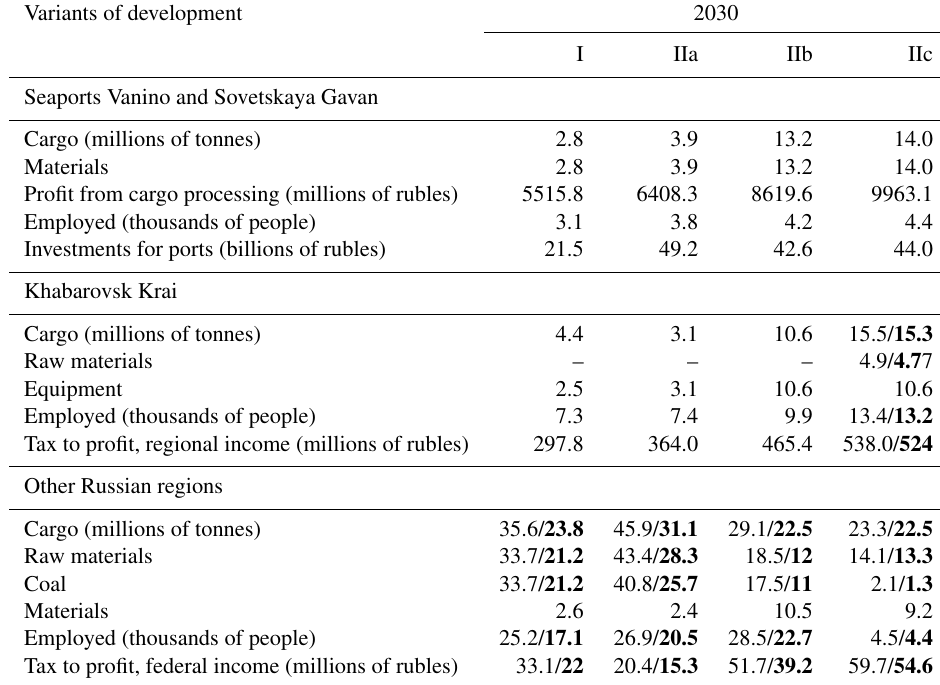
Table 2. Future state of seaports Vanino and Sovetskaya Gavan as beneficiaries to themselves, to Khabarovsk Krai and to the Russian Federation. Bold font indicates cases of environmental energy restructuring with a considerable decrease in coal demand in